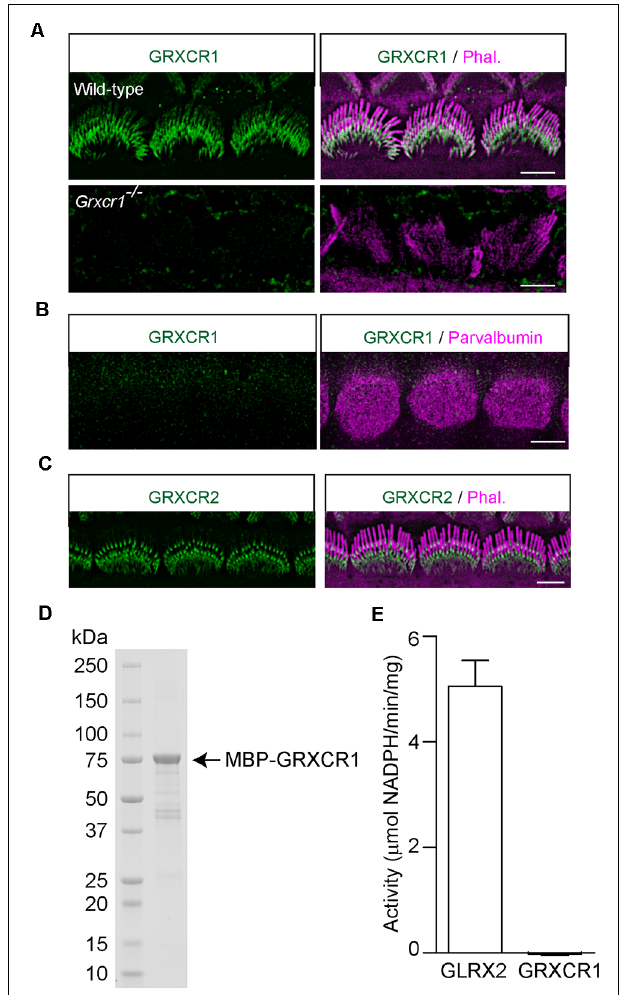
FIGURE 2 | Localization of GRXCR1 and GRXCR2 in hair cells. (A) Costaining of P7 cochlear whole mounts with GRXCR1-antibody (green)